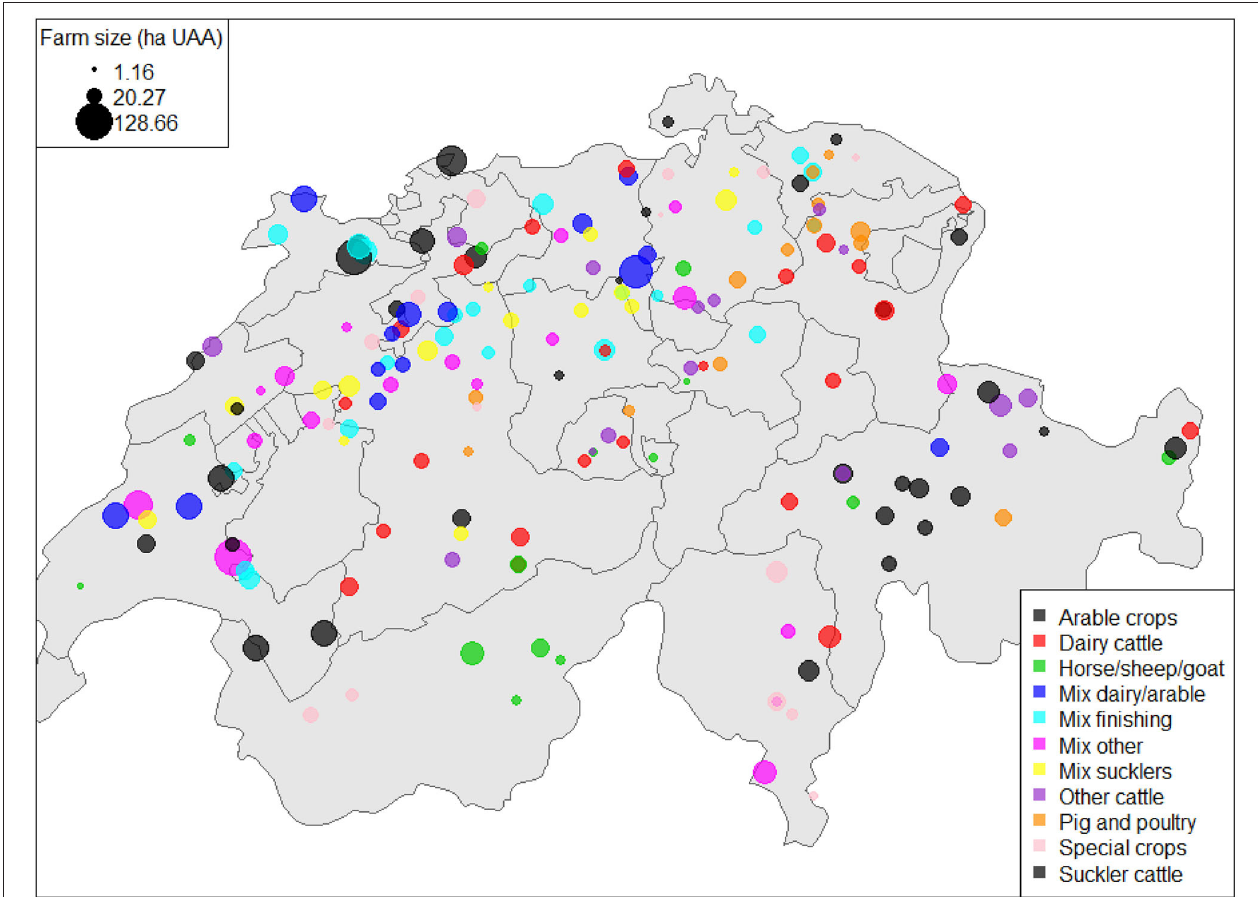
FIGURE 1 | Map of the location of sampled farms in Switzerland, grouped by farm type. Location data is intentionally approximate to preserve anonymity. UAA, Utilized Agricultural Area.